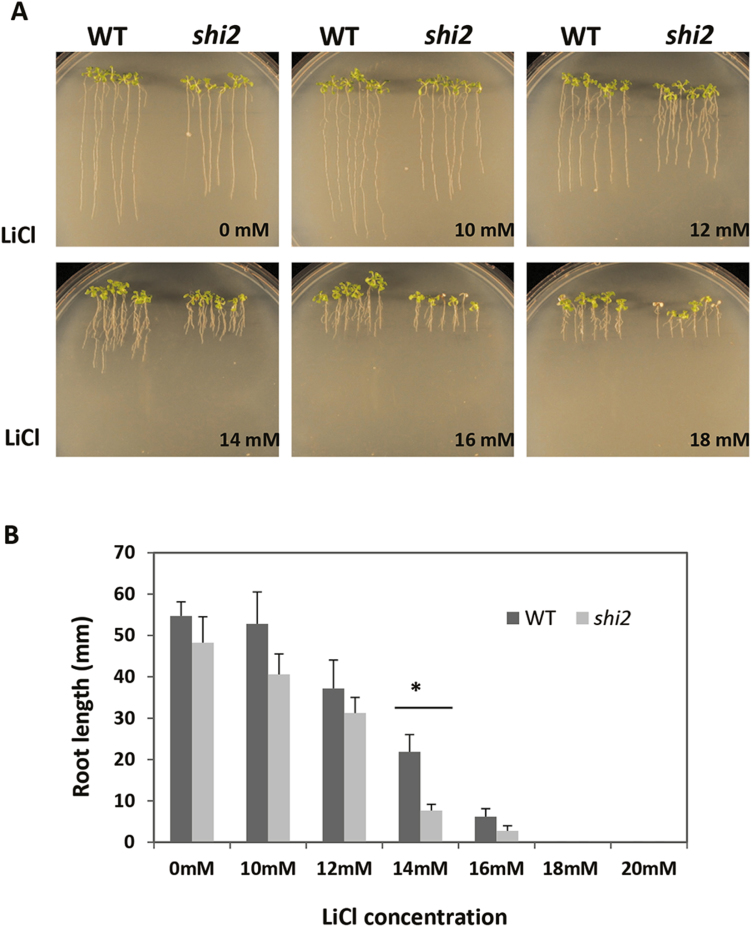
The shi2 mutant is more sensitive to LiCl than the wild type. (A) Root growth of the shi2 mutant and wild type in the presence of different concentrations of LiCl. (B) Quantitative measurement of primary root growth. Primary root length was measured on the 10th day after transfer to media containing different concentrations of LiCl. Data are means ±SD (n=15). Asterisks indicate a statistically significant difference (*P<0.05 by Student’s t-test). (This figure is available in color at JXB online.)